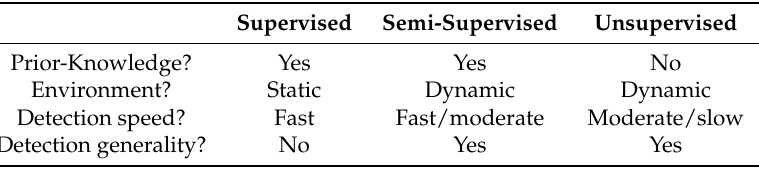
Table 2. Comparison of anomaly detection training methods.